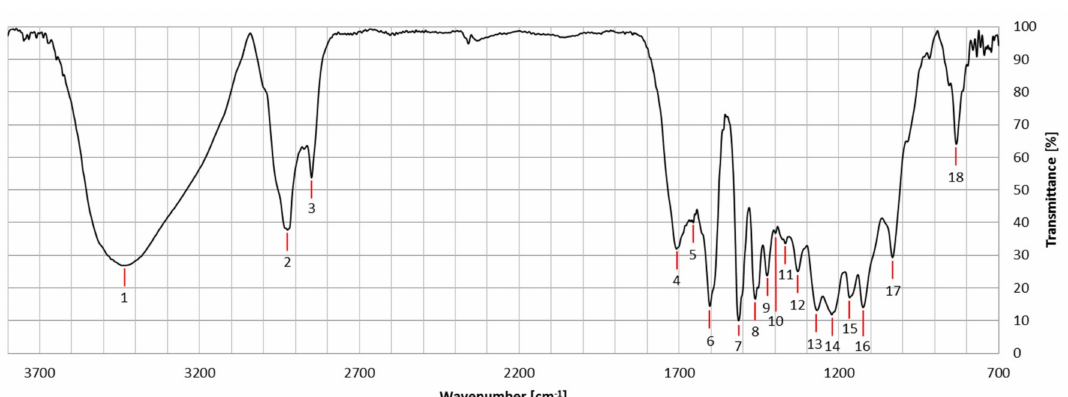
Figure 3. FT-IR spectra of Gig17 (stem, leaf, and mixture) with numbered signals listed in Table 4. Comparing the FTIR data of stem/leaf mixtures (Gig17M) versus separated biomass (Gig17L, Gig17S), similarities were found for mixture and stem-derived lignin (Figures 4 and